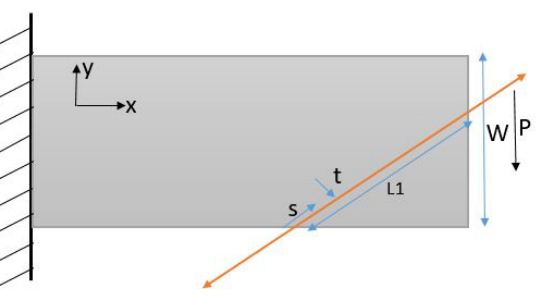
Figure 3. Cantilevered Beam Geometry with L = 20 mm , W = 10 mm , t = 5 mm , E = 200 GPa , ν = 0.3, I = tW 3 /12.